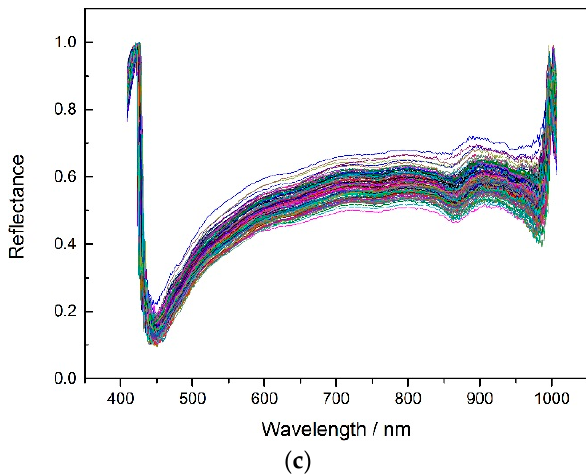
Figure 2. The average spectrums of ( a ) Haoyu21, ( b ) Haihe78 and ( c ) Jindan10.